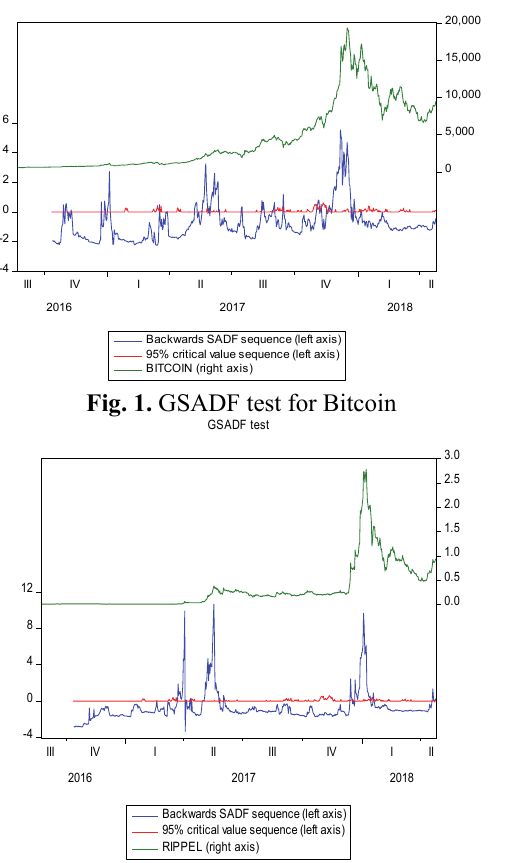
Fig. 3. GSADF test for Ripple Fig. 4. GSADF test for